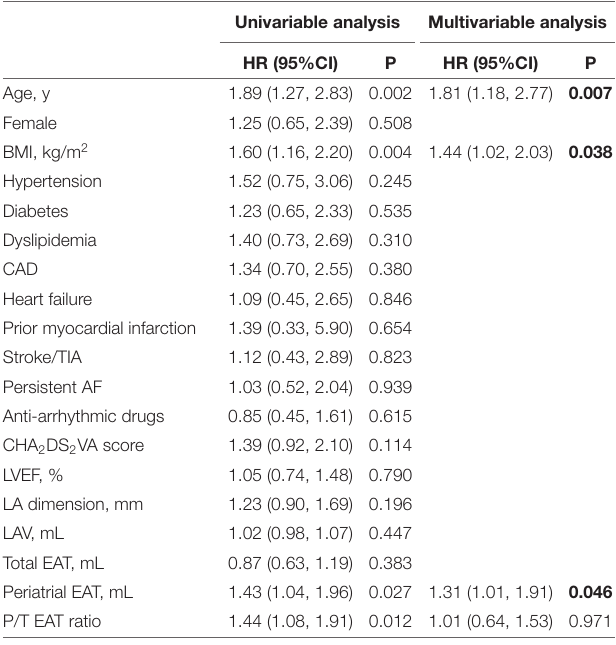
AF, atrial fibrillation; BMI, body mass index; CAD, coronary artery disease; TIA, transient ischemicattack;LVEF,leftventricularejectionfraction;LA,leftatrial;LAV,leftatrialvolume; EAT, epicardial adipose tissue. P/T EAT ratio; proportion of periatrial to total EAT. Bold values indicate P <